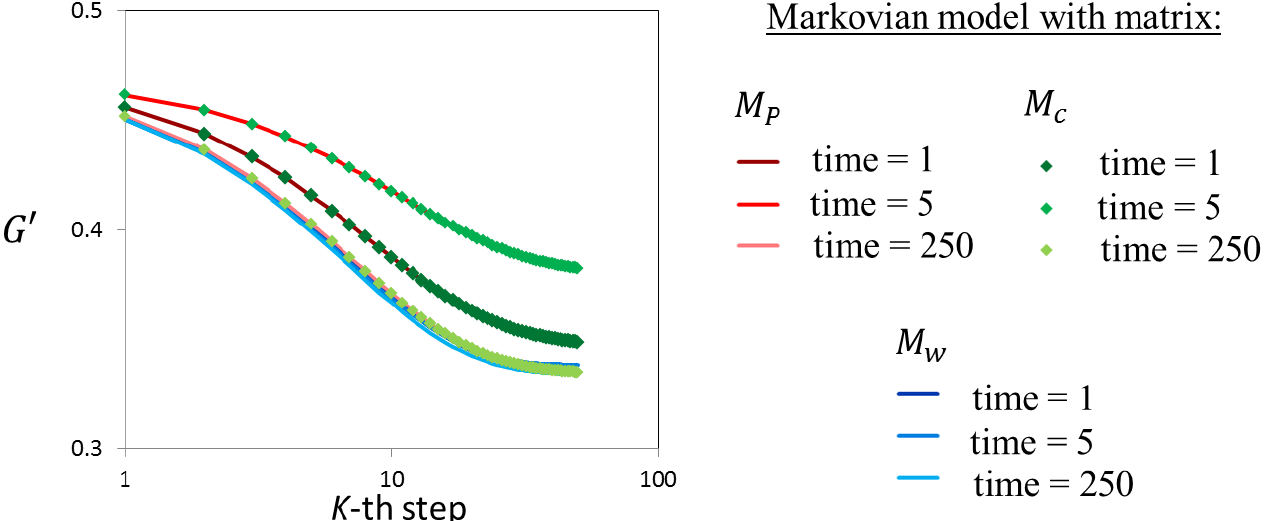
Figure 4. Time (step) evolution of global mixing state of Markov models using the computed mixing transition matrices M P , M c , and M w from RW simulations at different time steps. Note that the evolutions computed with the three M w are identical and identical to the evolution resulting from M p and M c computed after 250 RW time steps, when particles have exhaustively sampled the velocity distribution.